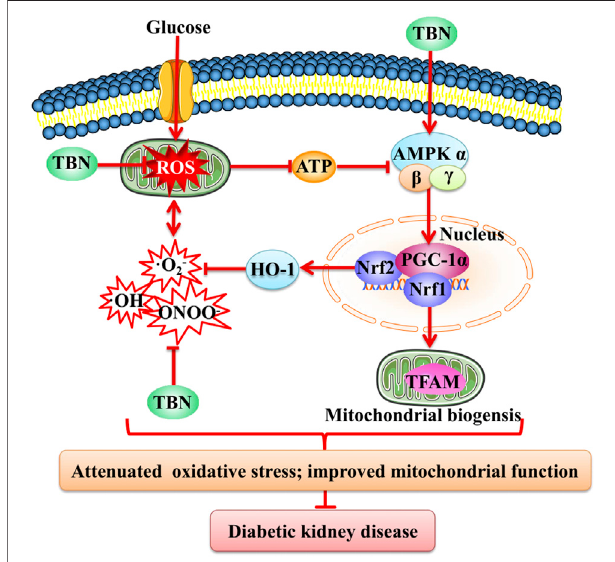
FIGURE 8| Schematic representation of the mechanism ofTBN against DKD. TBN improved mitochondrial biogenesis and renal function by inhibiting oxidative stress. HG, high glucose; ATP, adenosine triphosphate; AMPK, adenosine monophosphate activated protein kinase; PGC-1 α , peroxisome proliferator-activated receptor-gamma coactivator-1 α ; HO-1, hemeoxygenase-1;Nrf2,nuclearfactorerythroid-2-relatedfactor2;8-OHdG, 8-hydroxy-2 ′